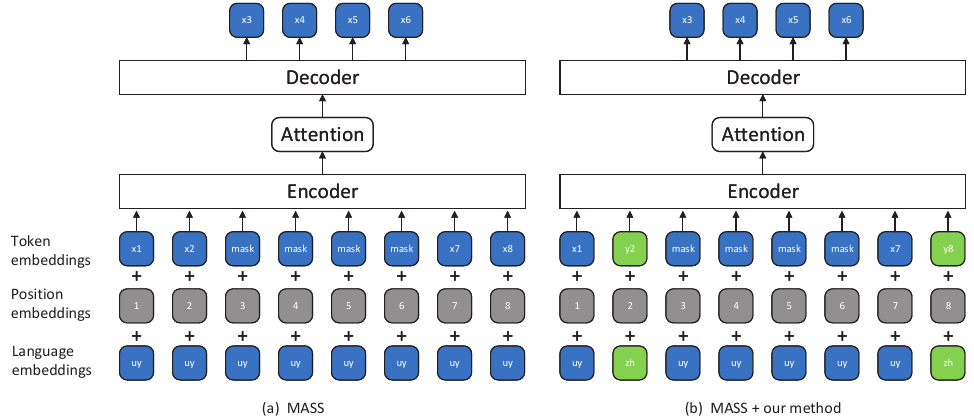
Figure 2. The examples of masked sequence to sequence (MASS) and our method based on MASS. ( a ) MASS randomly masks contiguous tokens and then predicts the masked tokens by unmasked to- kens and ( b ) our method based on MASS replaces some unmasked tokens with its translation